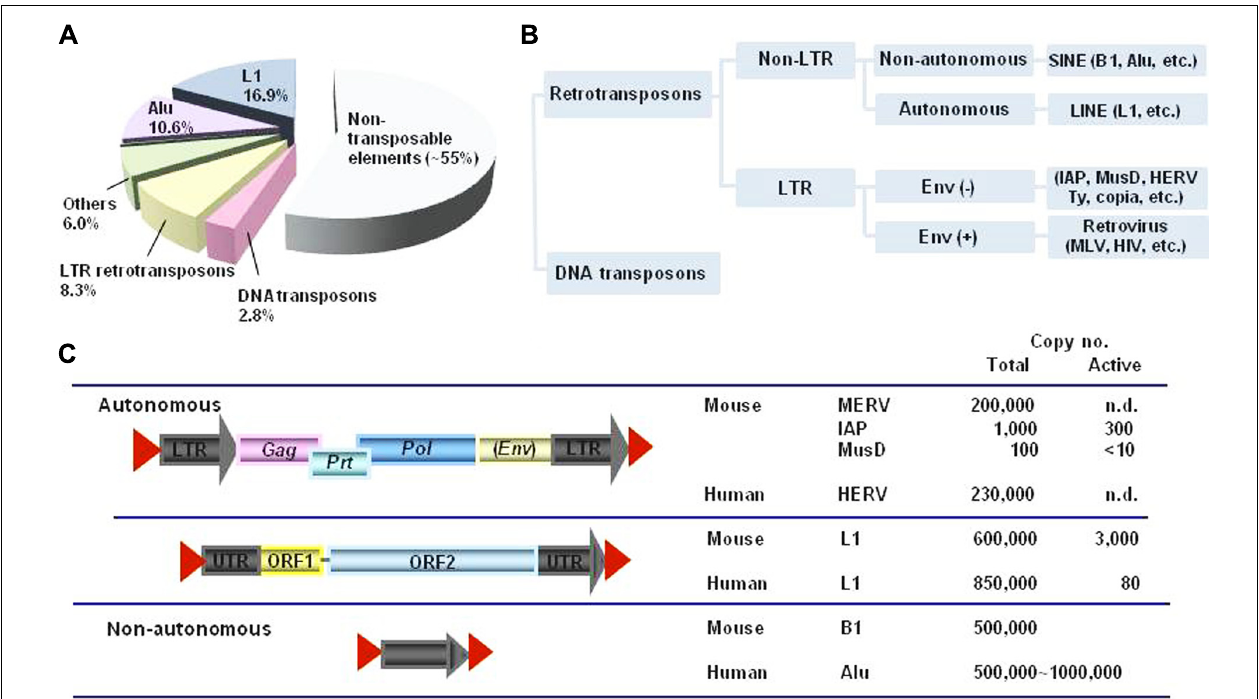
from one cell to another. In contrast, ERVs either lack this gene or contain a remnant of an env gene, and can integrate into the genome at a new site within their cell of origin. (C) The structure of retroelements and their estimated occurrence in the murine and human genomes. ERVs contain slightly overlapping open reading frames (ORFs) for their group-specific antigen (Gag), protease (Prt), polymerase (Pol), and terminal LTRs.The pol genes encode a RT, ribonuclease H, and integrase to generate proviral cDNA from viral genomic RNA and to insert it into the host genome. L1 elements possess two ORFs. A ∼ 6 kb functional L1 element contains an internal RNA polymerase II promoter in its 5 (cid:3) untranslated region (UTR), followed by two ORFs. ORF1 encodes an RNA-binding protein (ORF1p) that is required for ribonucleoprotein particle (RNP) formation in the cytoplasm. ORF2 encodes a protein with endonuclease (EN) and RT activity (ORF2p). A short 3 (cid:3) -UTR is followed by a poly(A) tail, and the entire element is flanked by target site duplications (TSDs) indicated by red triangles. An Alu element is an example of a non-autonomous retrotransposon (adapted with permission from Esnault etal.,